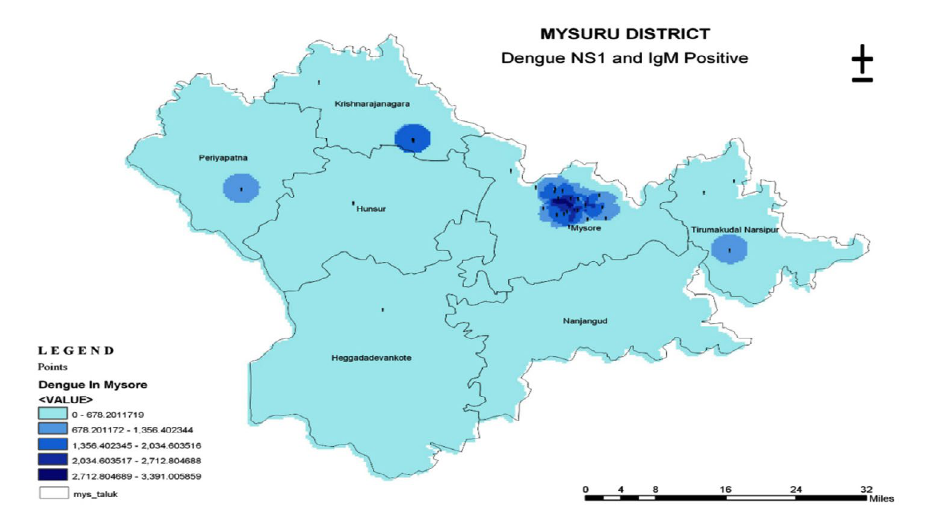
Map 1. Geographical Representation of Dengue Positivity in Mysuru